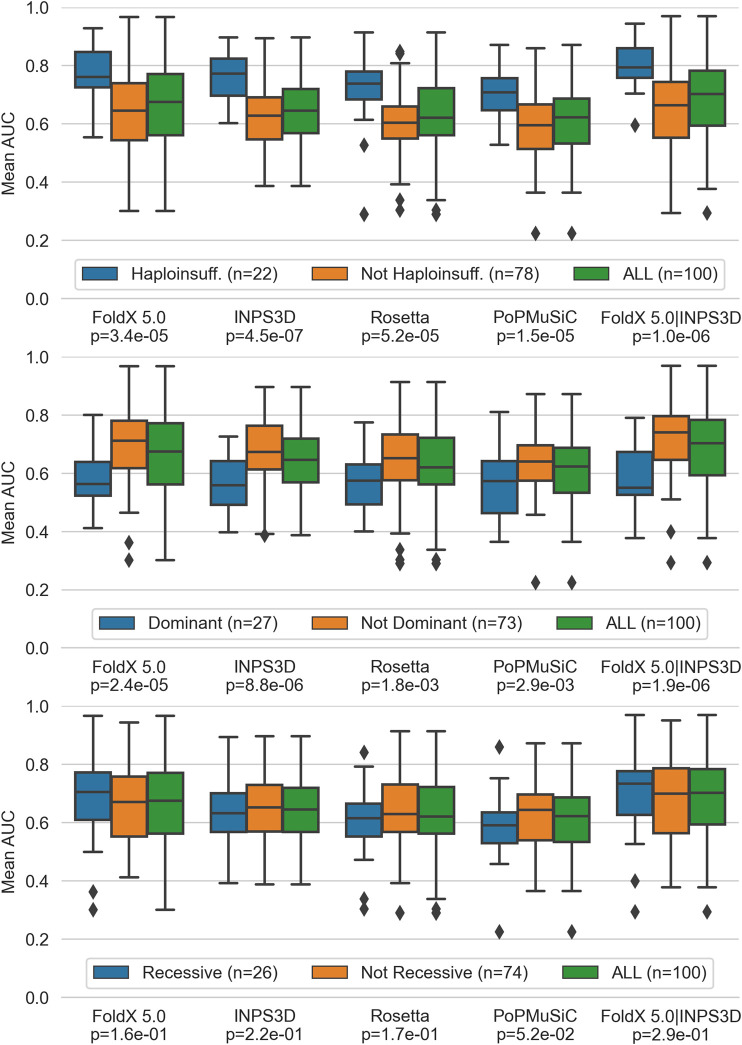
Performance of top performing predictors, (i.e. FoldX 5.0 and INPS3D, Rosetta and PoPMuSiC along with the combined scores of the first two) split by haploinsufficient, dominant without haploinsufficiency and recessive genes. P-values of the pairwise comparison between each gene group and its complement by the Mann-Whitney U test are reported at the bottom of the x-axis.